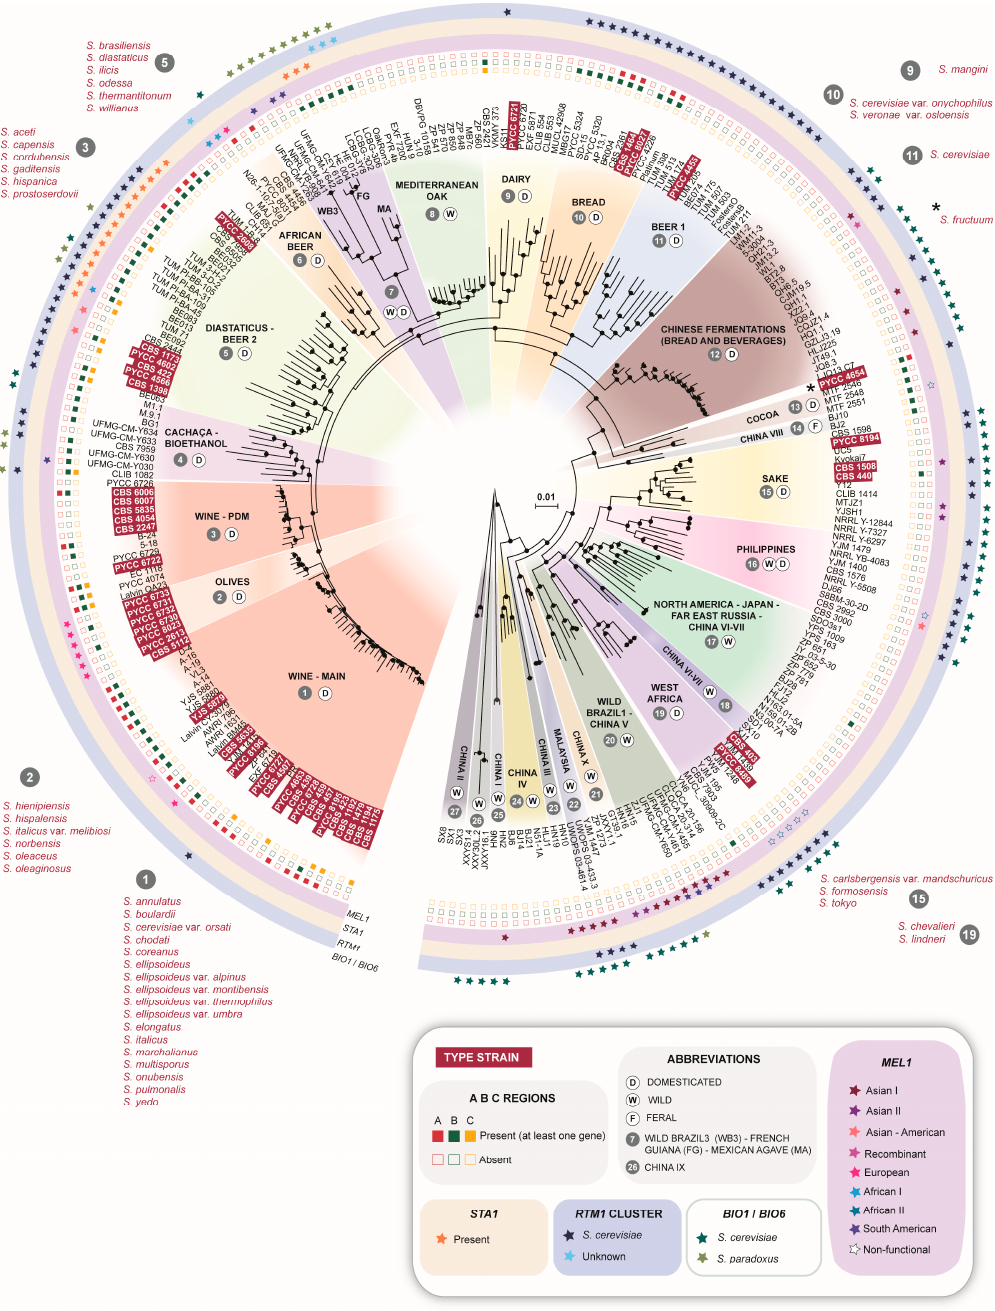
Figure 1. Current synonyms of S. cerevisiae are unequally distributed among the known lineages of the species. The phylogeny was inferred from 248 sequences and 1,520,302 single nucleotide polymorphisms using the TVM + F + ASC + G4 model of sequence evolution and the maximum likelihood method as implemented in IQ-TREE and was rooted with S. paradoxus . Branch lengths correspond to the expected number of substitutions per site and black dots in tree nodes depict bootstrap support values above 95% (1000 replicates). The 27 clades detected are numbered in gray circles, the former type strains of current synonyms of S. cerevisiae are highlighted in red